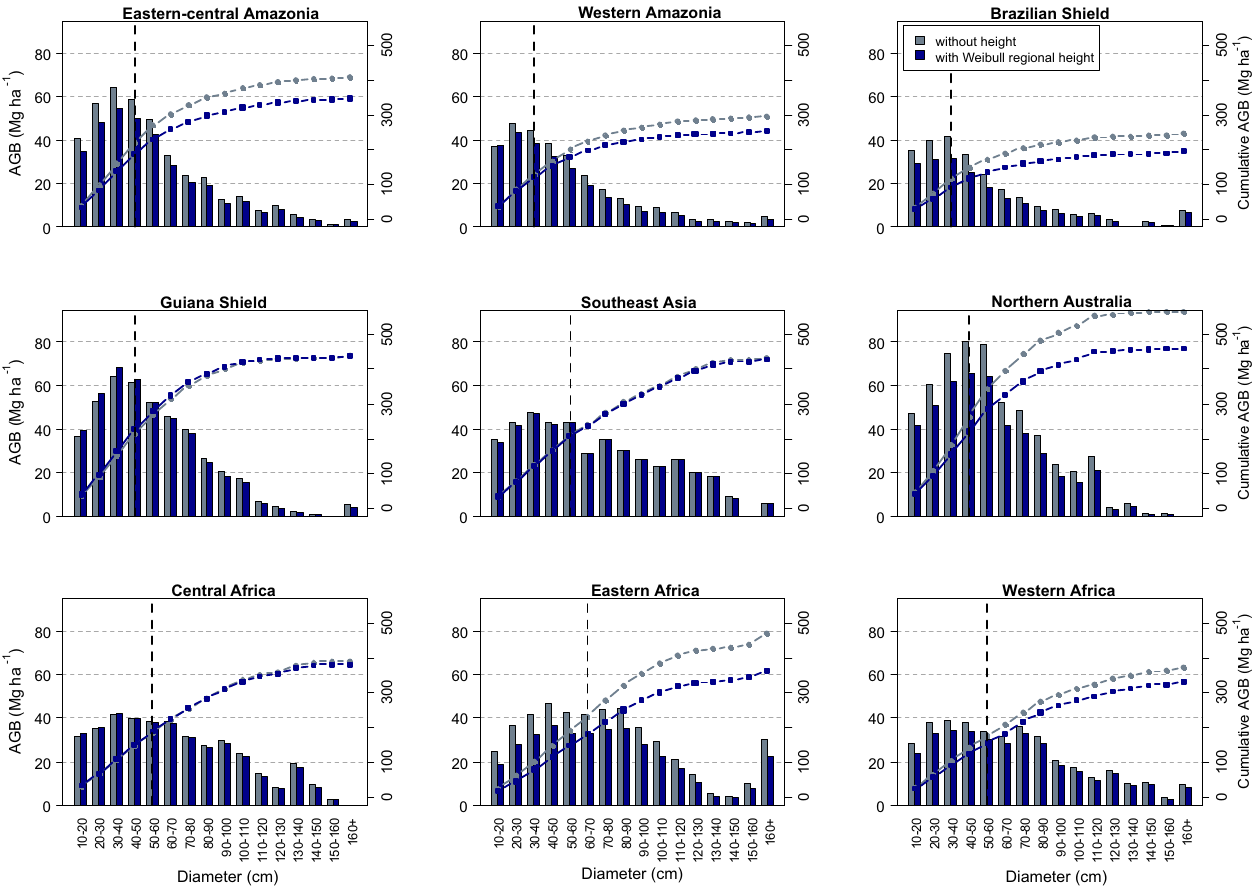
Fig. 3. Biomass (Mgha − 1 ) distribution (bars) among diameter class (cm) by region with cumulative aboveground biomass (AGB) (Mgha − 1 ) on the second axis (lines) for trees in pantropical permanent plots. Tree-by-tree biomass was estimated by model (1) without H , or model (2) with Weibull (Eq. 5) region-specific H . The vertical dashed line represents the mid-point in biomass storage above and below the indicated diameter bin. See Table 4 for differences in biomass estimates due to H